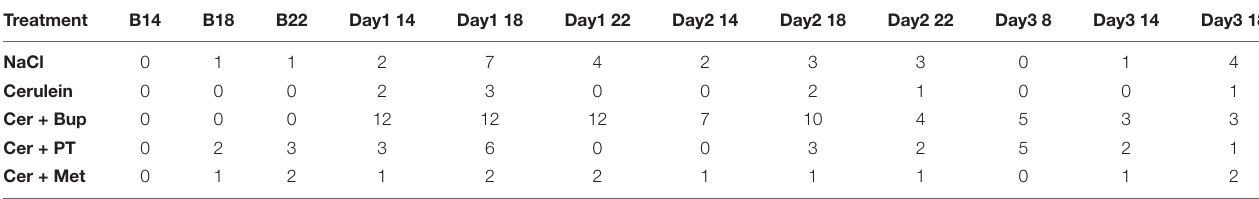
FIGURE 4 | Absolute body weight in grams measured on the day before experimental treatment (Baseline), immediately before the first (Day 1) and the second (Day 2) injections, on the morning of Day 3, and on the harvest day. Arrows indicate injection time points (green = NaCl, red = Cerulein). Bonferroni corrected post hoc test showed a lower body weight on Day 1 inCer + Met compared with Cer. On Day 2, Cer + Met body weight was lower than NaCl and Cer. On Day 3, Cer + Met body weight was lower than NaCl, Cer, Cer + Bup. On the day of harvest, Cer + Met body weight was lower than all other groups. * Significant ( p ≤ 0.05, Dunnett’s post hoc ) differences to the baseline weight within one treatment group. Data are shown as scatter dot plot with mean ± SD. NaCl n = 18, Cer n = 17, Cer + Bup n = 16, Cer + PT n = 15, Cer + Met n = 16. TABLE 1 | Number of animals exhibiting pressing or stretch-and-press-behavior at the respective time points of assessment at baseline and experimental days (14:00, 18:00, 22:00 and